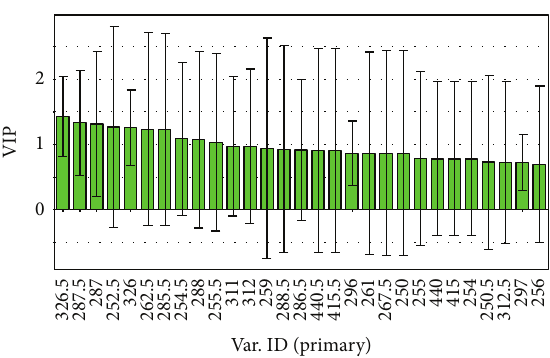
Figure 5: Distance to model in X-space (DModX) of all the specimens.